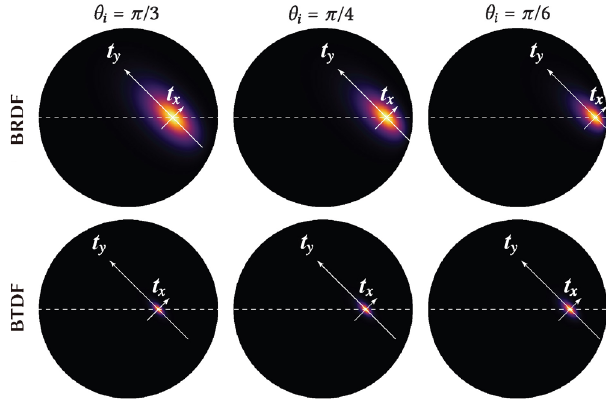
Fig. 1 Our method works for layers with anisotropic NDFs defined on varying tangent vector fields, whereas the previous method [7] can be applied only to isotropic NDFs.